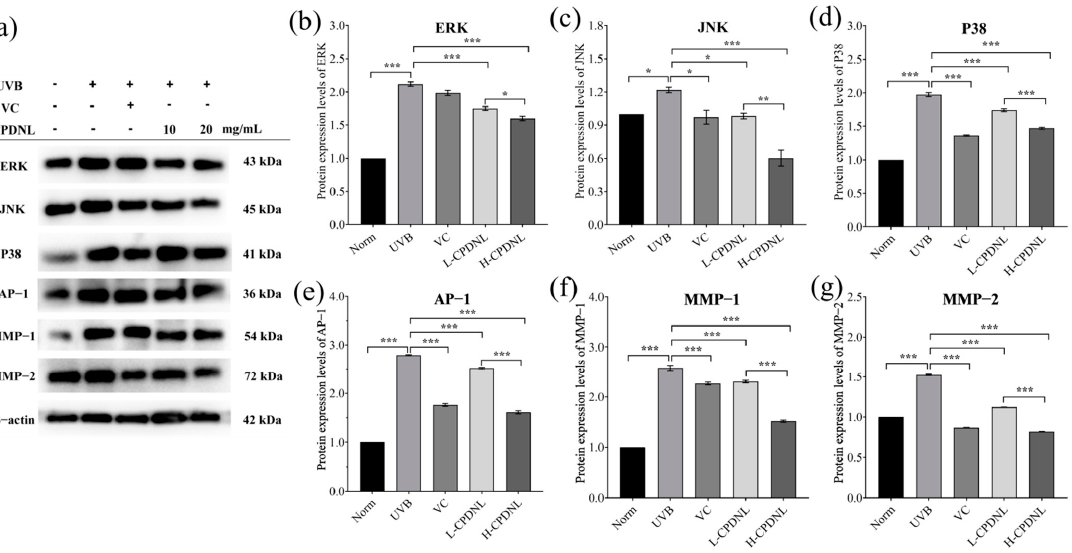
Figure 10. The effect of CPDNL on protein level of MAPK/AP-1/MMP signaling pathways in UVB-induced skin. The protein expression level ( a ) of ERK ( b ), JNK ( c ), P38 ( d ), AP-1 ( e ), MMP-1 ( f ), and MMP-2 ( g ) was determined by Western blot analysis. Data are presented as mean ± SEM. * p < 0.05, ** p < 0.01, and *** p < 0.001.